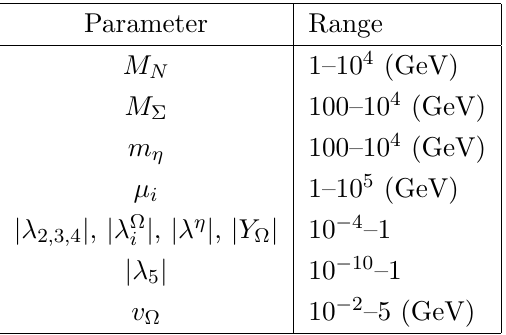
Figure 2 . Parameter space that is fully consistent with DM and neutrino physics in the STFDM model. In color, we show the variable (cid:24) de(cid:12)ne in eq. (3.1). High values of (cid:24) is the limit for singlet fermion DM N and low values correspond to the limit for triplet fermion DM (cid:24)